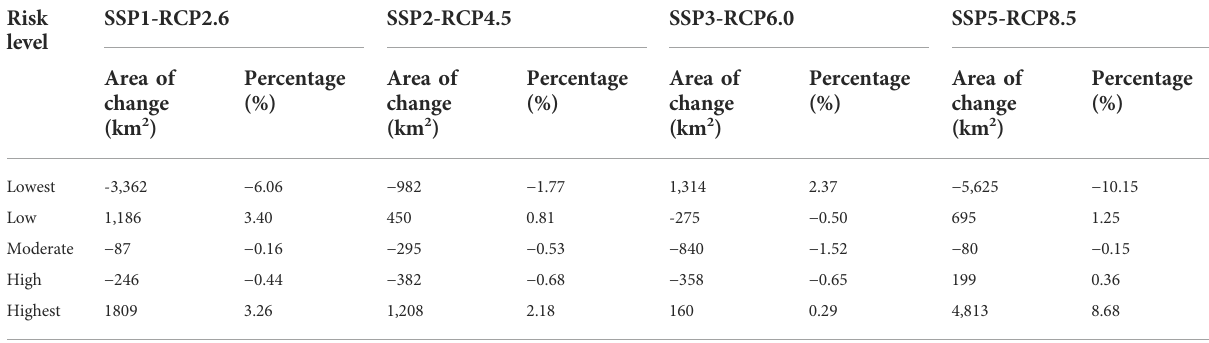
TABLE 6 Projected changes of fl ooding risk areas under four scenarios in 2030 compared with the original scenario. (Area of risk zones for different scenarios in 2030 minus the area of risk zones corresponding to the original